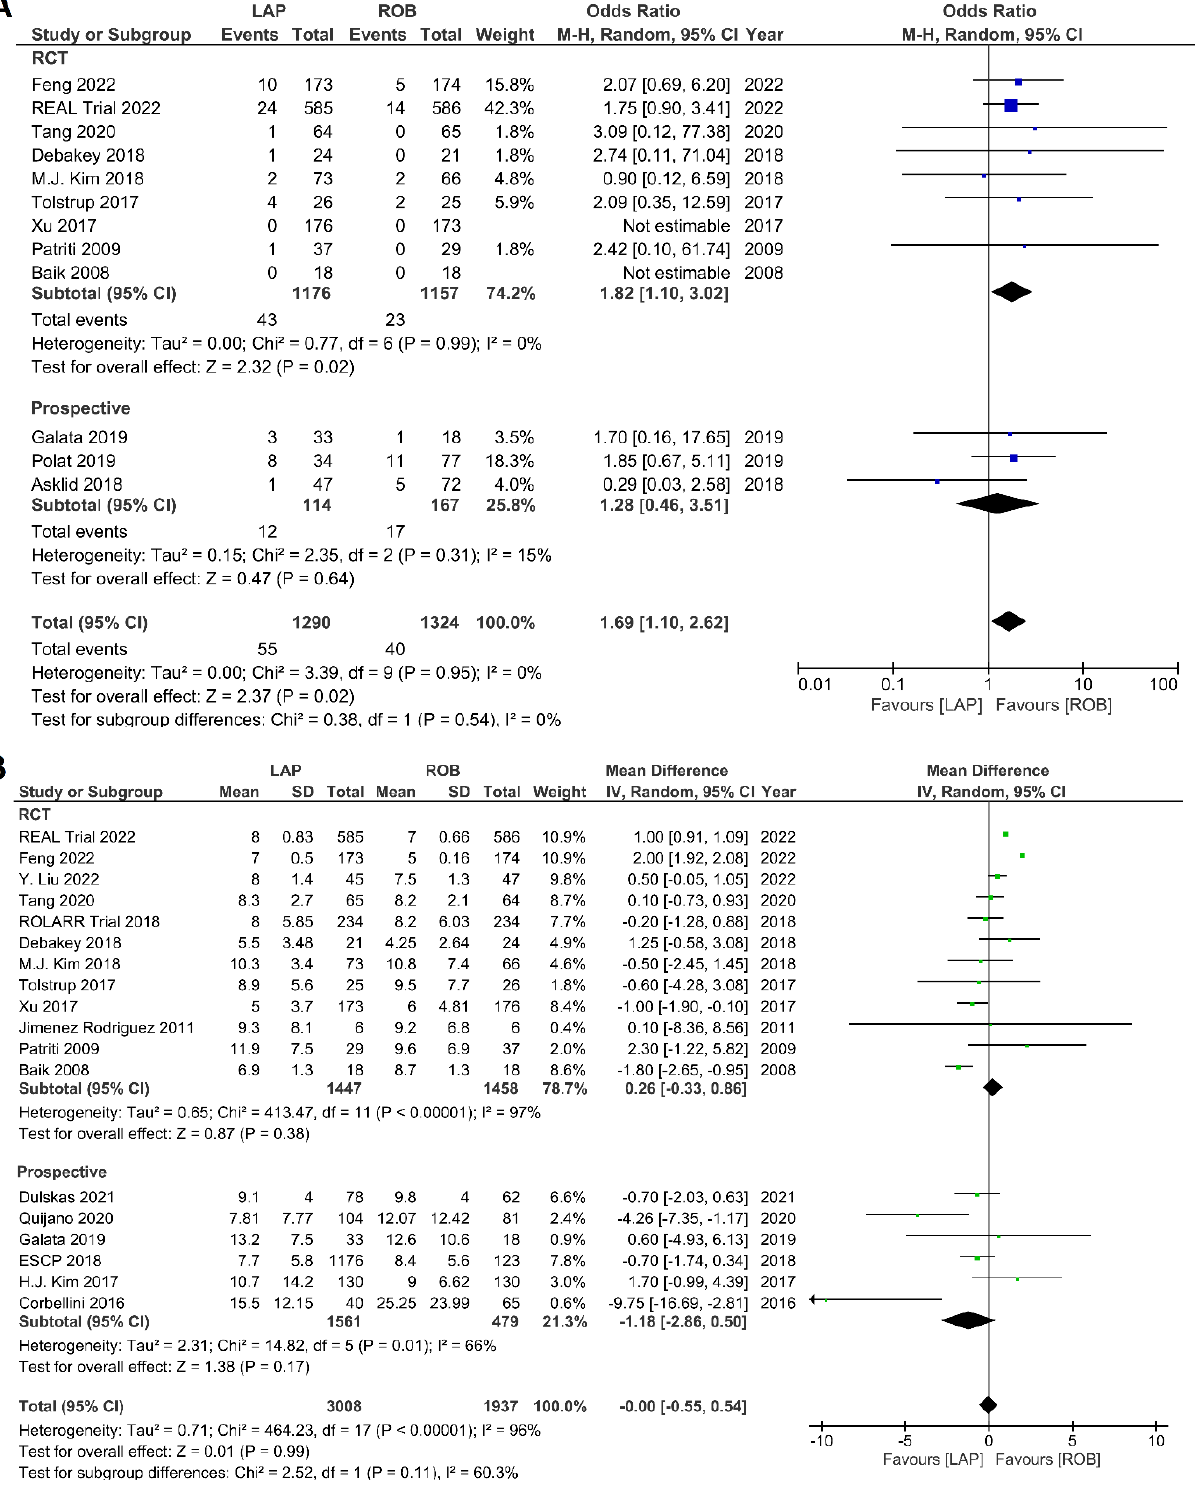
Figure 10. Forest plots comparing ( A ) reoperation [6,17,23,35,37,38,40 – 42,45,48,52] and ( B ) length of hospital stay [6,17 – 19,23,34 – 38,40 – 44,47 – 49,53] between robotic and laparoscopic rectal resection (blue boxes representing odd ratios, green boxes representing mean differences, arrows representing 95% confidence intervals, and diamonds representing point estimates of pooled odd ratios or mean differences).